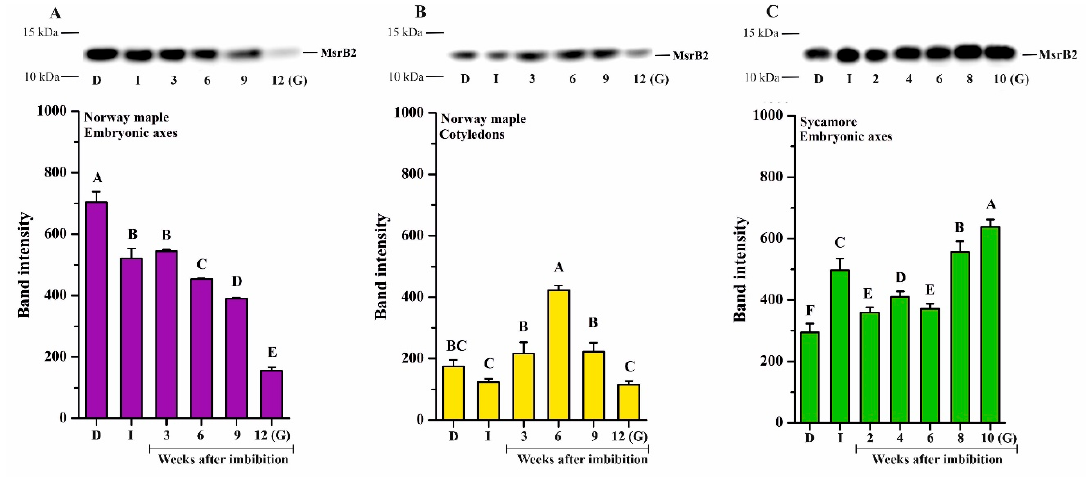
Figure 6. Western blot analysis and densitometry analysis of MsrB2 protein in the embryonic axes ( A ) and cotyledons ( B ) of dry and germinating Norway maple seeds and in the embryonic axes of D and germinating sycamore seeds ( C ). Abbreviations: D, Dry seeds; I, Imbibed seeds; G, Germinated seeds. The data are the means of three independent replicates ± the STDs. The same letters indicate groups that are not significantly different according to Tukey’s test.